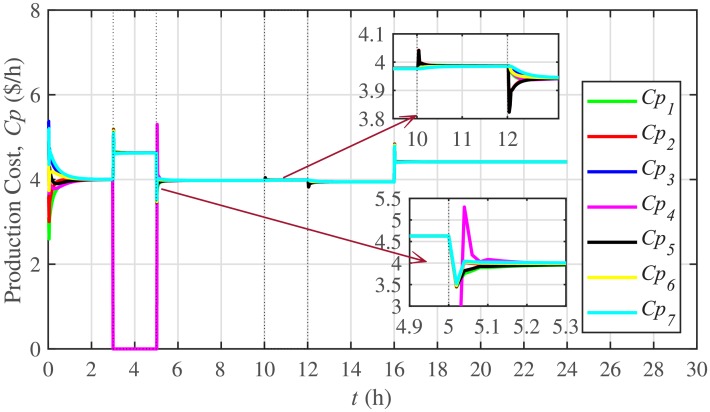
Production costs consensus under case 2.